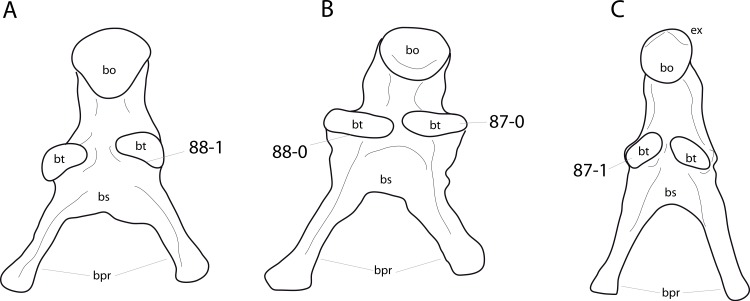
Diplodocid basioccipital-basispenoid complex.Basioccipital-basispenoid complex of Apatosaurus louisae CM 11162 (A), Kaatedocus siberi SMA 0004 (B; traced from a photo by J Marinheiro), and Diplodocus sp. CM 11161 (C) in posteroventral view. Note the differing orientations of the longest axes of the basal tubera (B; C87-0; in contrast to C; C87-1), as well as the concave (A; C88-1) versus the straight to slightly convex anterior edge of the tubera (B; C88-0). Abb.: bo, basioccipital; bpr, basipterygoid process; bs, basisphenoid; bt, basal tuber; ex, exoccipital. Drawings not to scale.